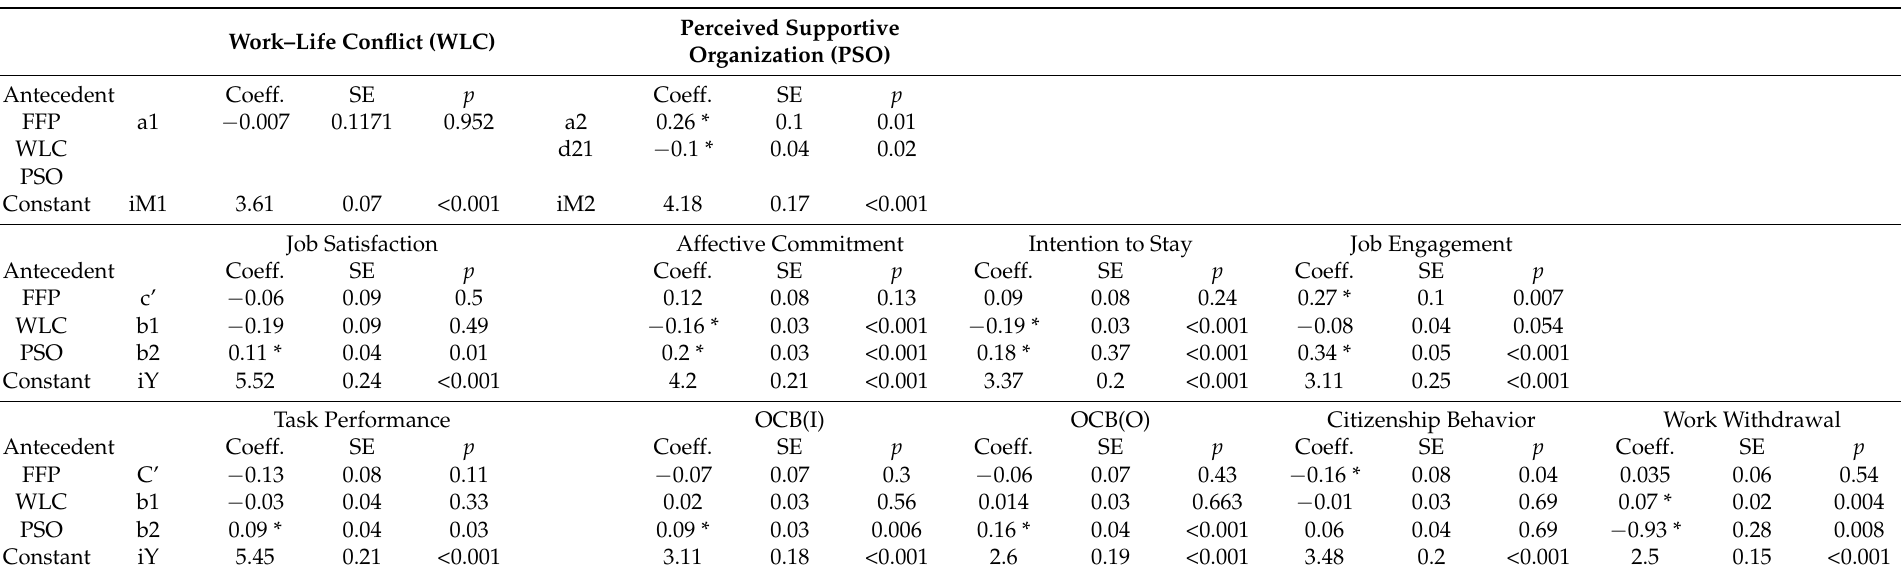
Table 2. Association of availability and utilization of family-friendly policies with work attitude and behavior through work–life conflict and perceived support of